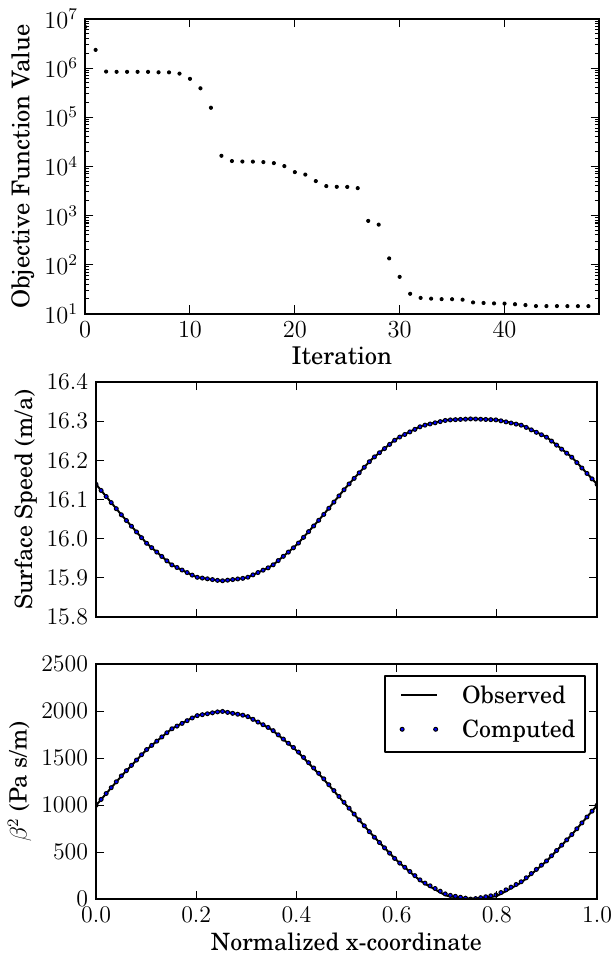
Fig. 8. Convergence profile and modelled basal traction and velocity from inverting ISMIP-HOM C using the first-order approximation. RMS between observed and modelled velocities is 5 × 10 − 3 ma − 1